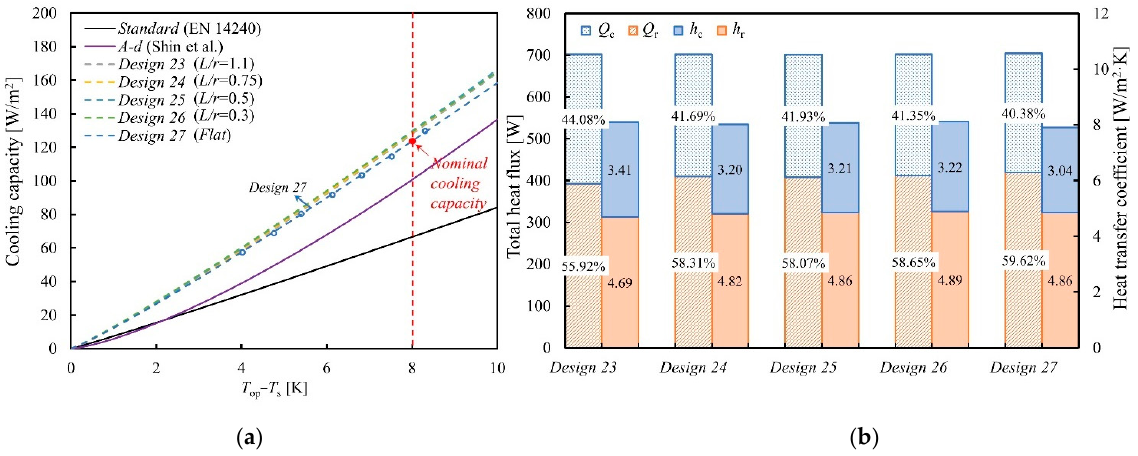
Figure 12. Comparison of different L / r ratios ( a ), cooling capacity curves [27,32] ( b ), and thermal performances under a cooling load of 1405.02 W.